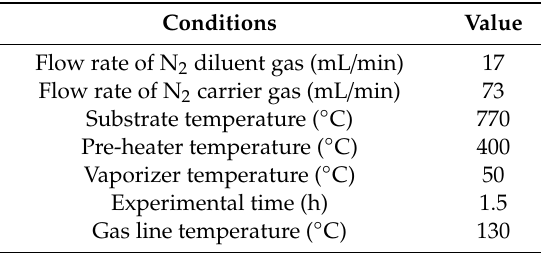
Table 2. Parameters of the coking